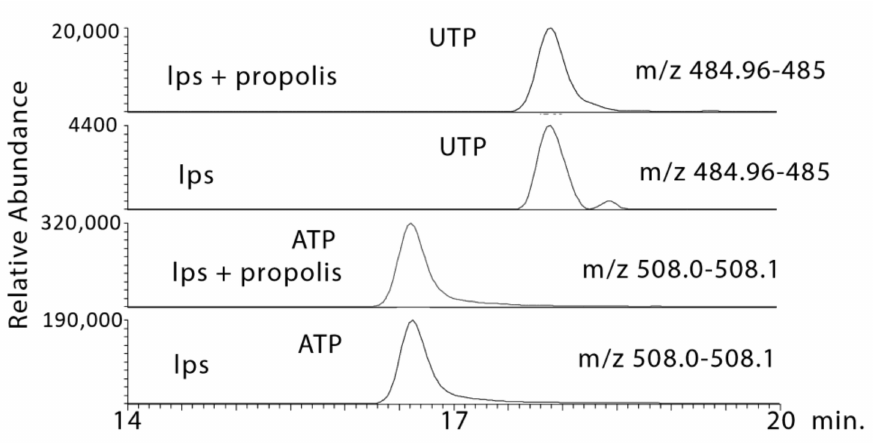
Figure 9. Extracted ion traces showing increases in UTP and ATP in LPS-stimulated macrophages treated with propolis.